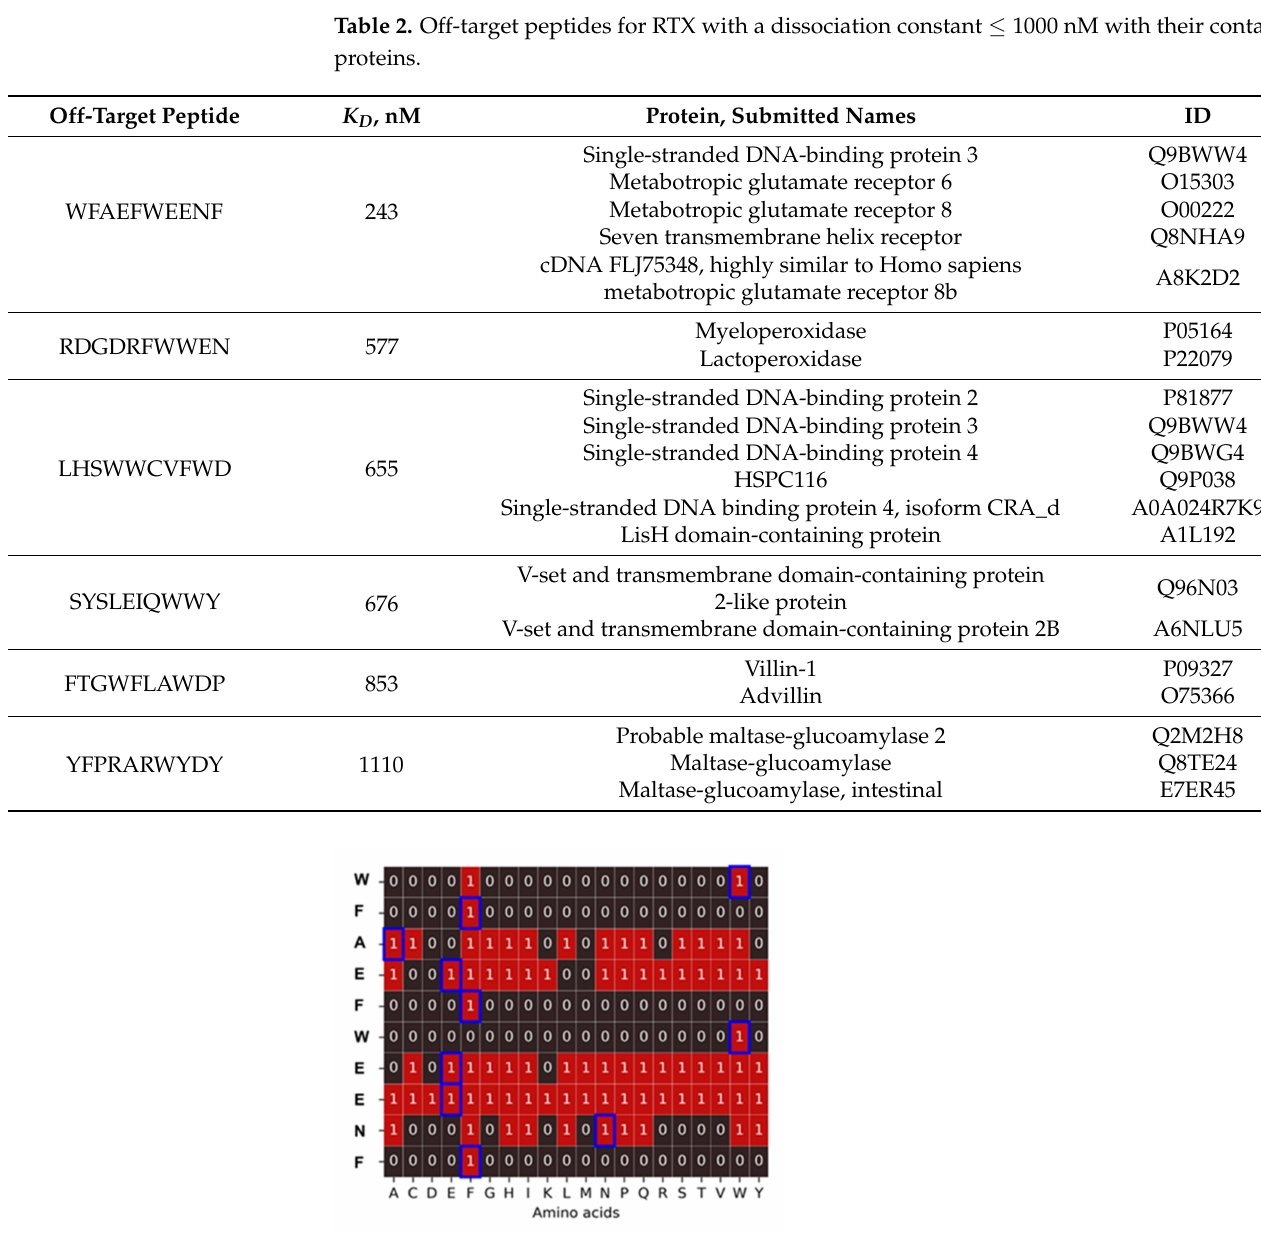
Figure 10. Substitution analysis for the peptide WFAEFWEENF. The blue frames correspond to the amino acids of the peptide under study. Squares show the corresponding fluorescent signal for all substitution sequences. In the case of red squares, the signal is equal to or higher than the signal from the original sequence. The epitope is composed of a combination of the invariant amino acids, W and F: